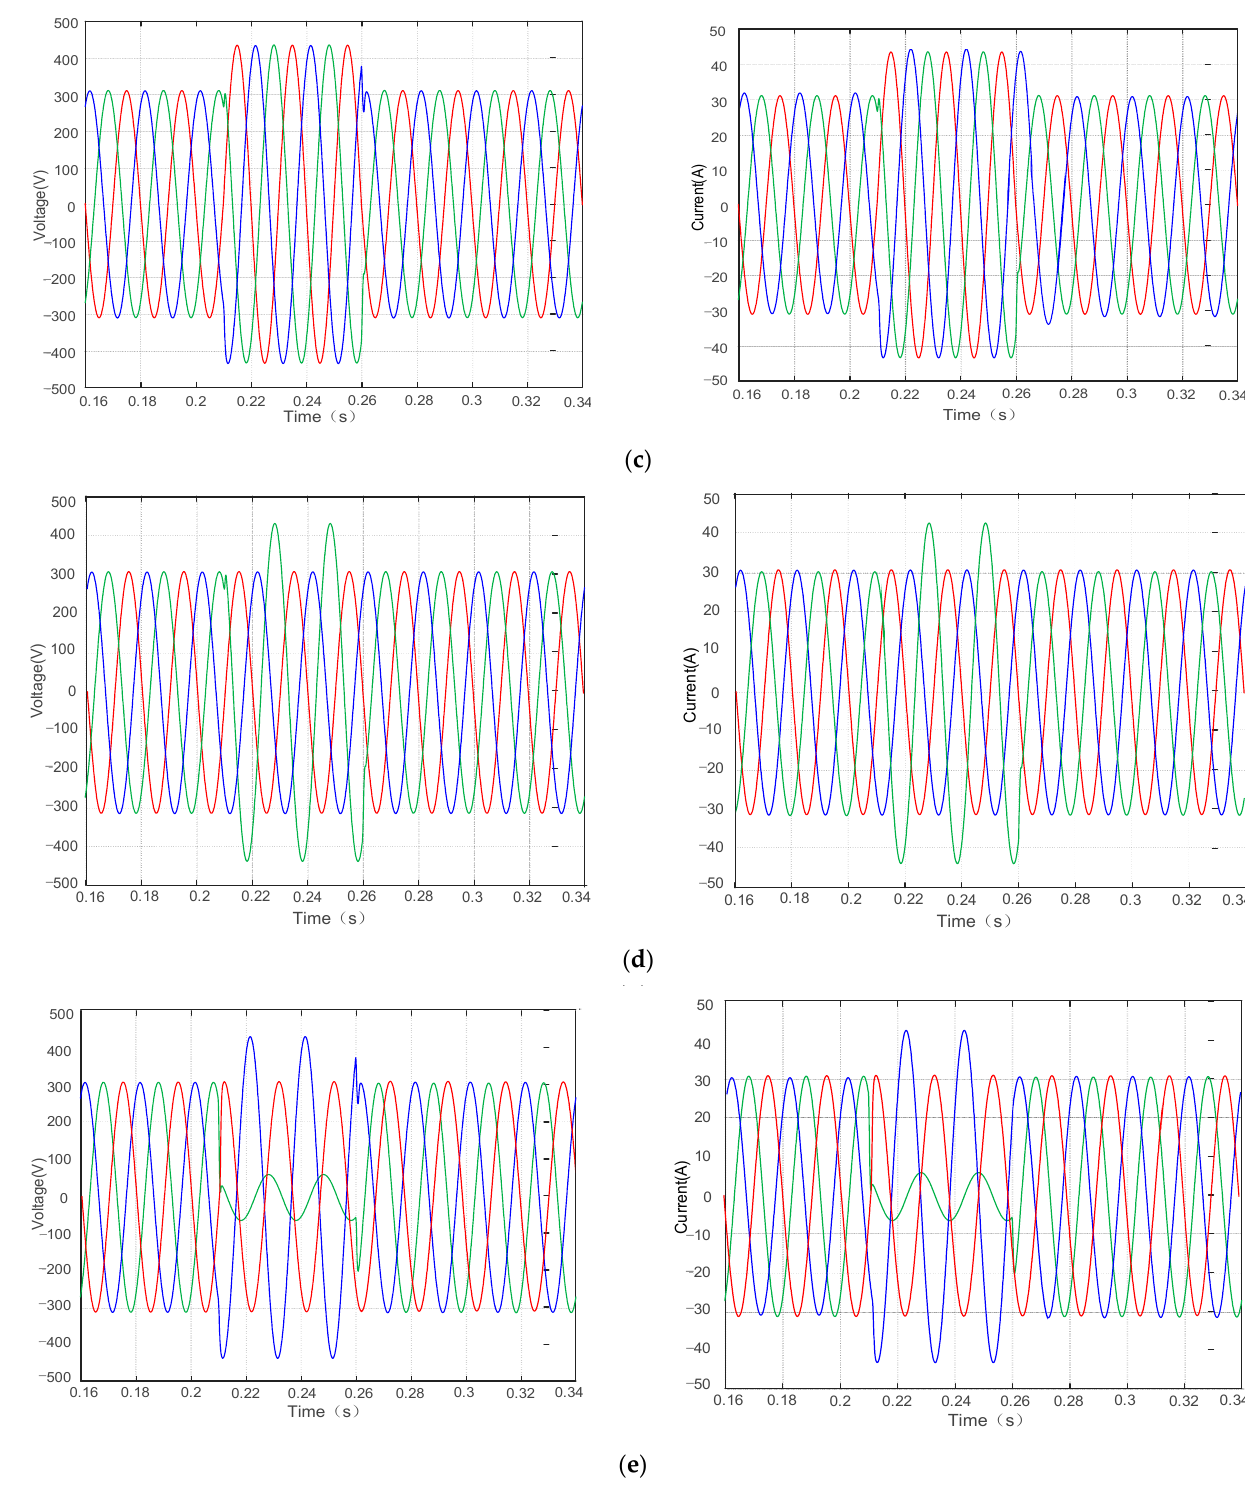
Figure 11. Simulation voltage waveforms. ( a ) Three-phase sags to 20% (0.2 pu). ( b ) Single-phase sags to 20% (0.2 pu). ( c ) Three-phase swells to 140% (1.4 pu). ( d ) Single-phase swells to 140% (1.4 pu). ( e ) Phase A swells to 140% (1.4 pu), phase B sags to 20% (0.2 pu), and phase C phase angle jumping 60°.